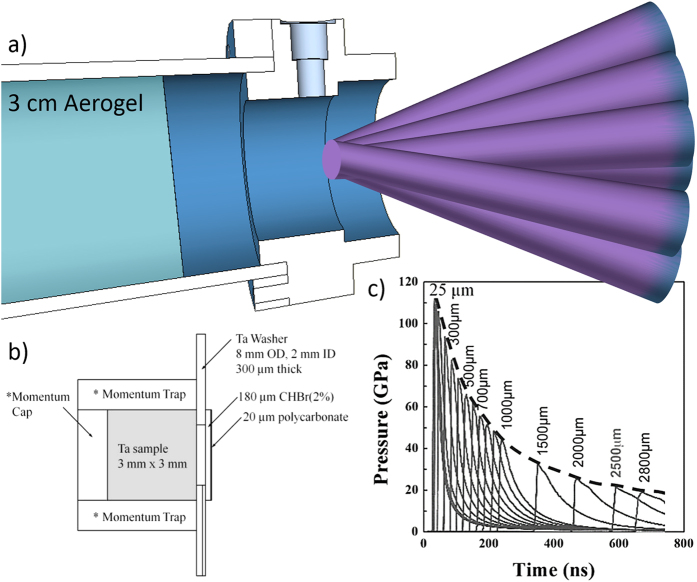
(a,b) Assembly used to shock compress the Ta monocrystals; notice momentum trap; (c) calculated pressure (using 1-D LASNEX and normalization parameter) as a function of depth for laser shock energy of 684 J.